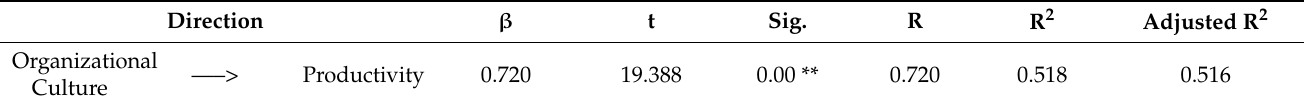
Table 9. Results of the